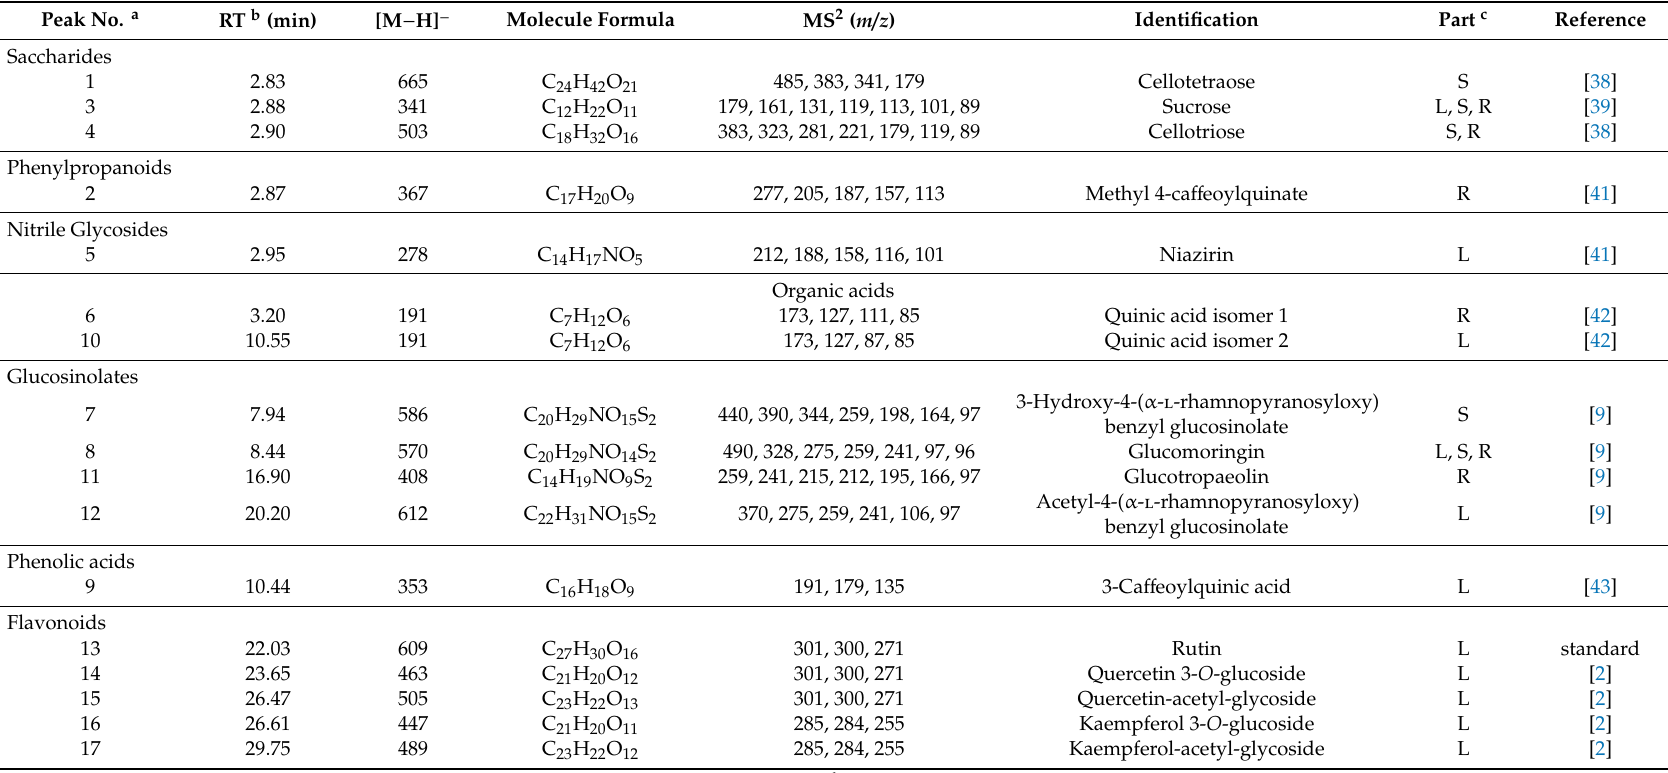
Table 2. Compounds identified from leaves, seeds and roots of M. oleifera by LC-MS /